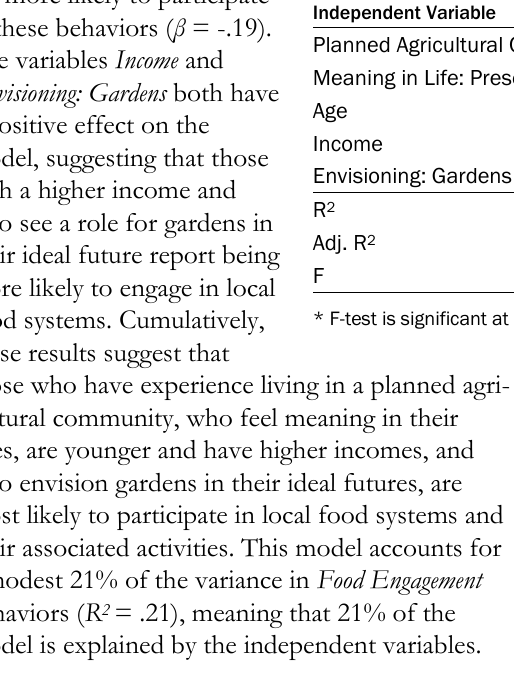
Table 9. Dependent Variable: